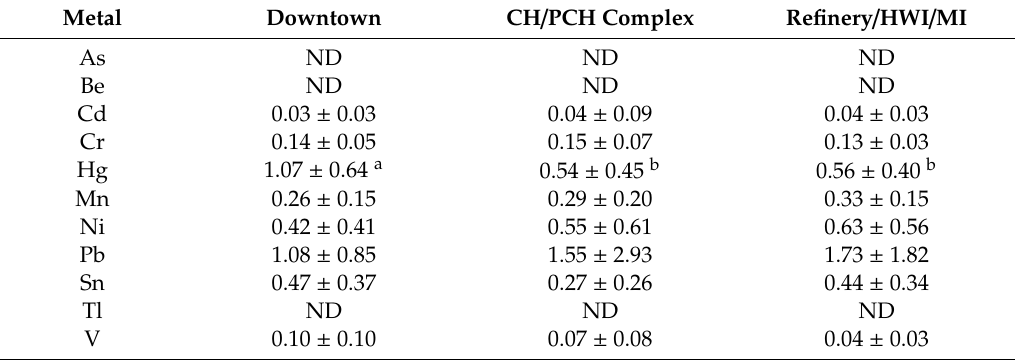
Table 3. Metal concentrations ( µ g / g) in hair of school children living in Tarragona County according to the specific zones of residence